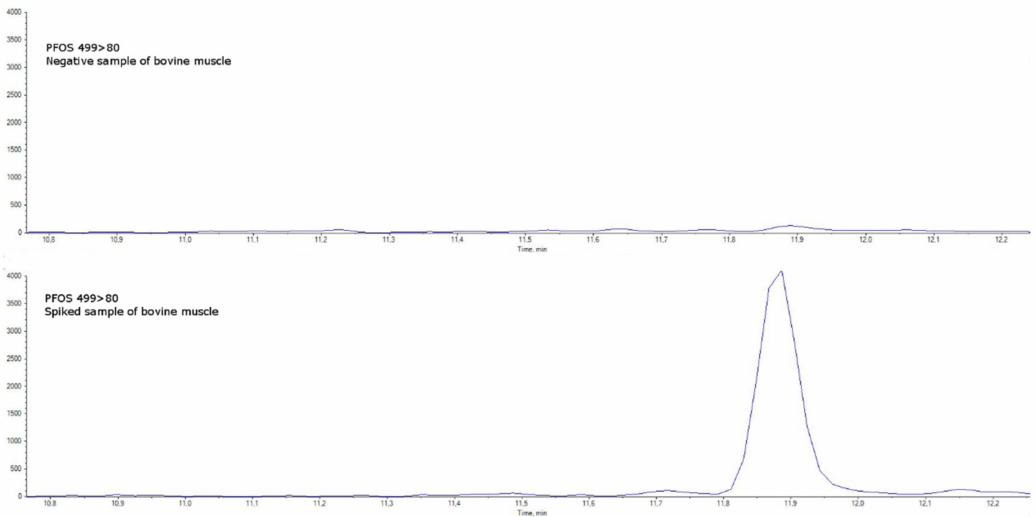
Figure 5. (PFOS quantitative transition 499 > 80). Comparison between a negative sample of bovine muscle (upper chromatogram) and a spiked sample of bovine muscle at the limit of quantification (lower chromatogram).